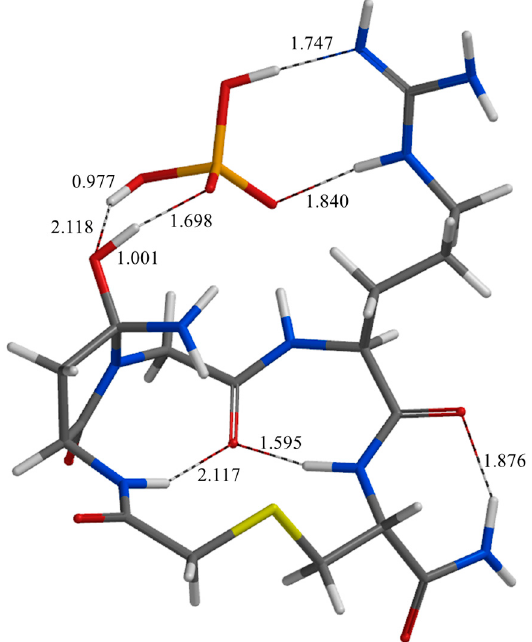
Figure 5. The geometry of IC1* (intermediate complex 1) lying between TS1* (Figure 2) and TS2 (Figure 6). Selected interatomic distances are shown in Å. Grey: carbon; white: hydrogen; blue: nitrogen; red: oxygen; orange: phosphorus; yellow: sulfur. This geometry can be reproduced from the Cartesian coordinates reported previously [67].